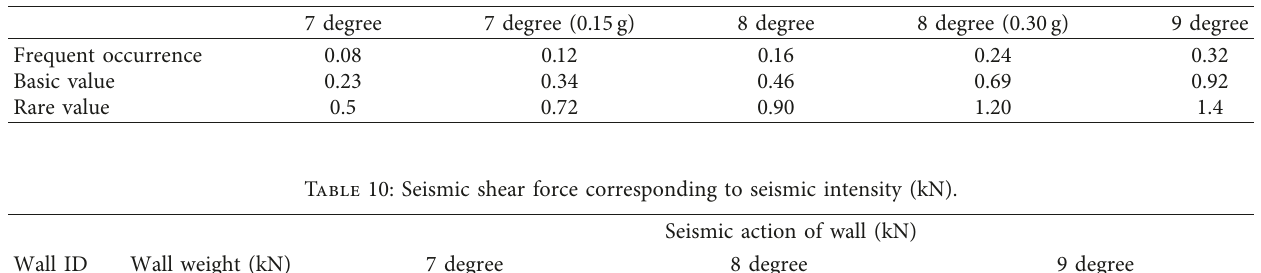
Table 9: Maximum impact coefficient of horizontal earthquake (cm/s 2 ).